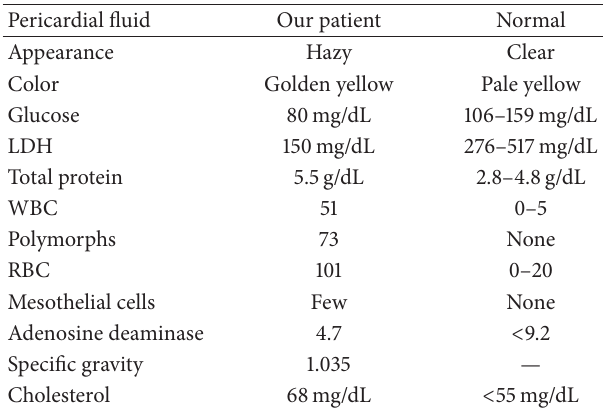
Table 1: Pericardial fluid